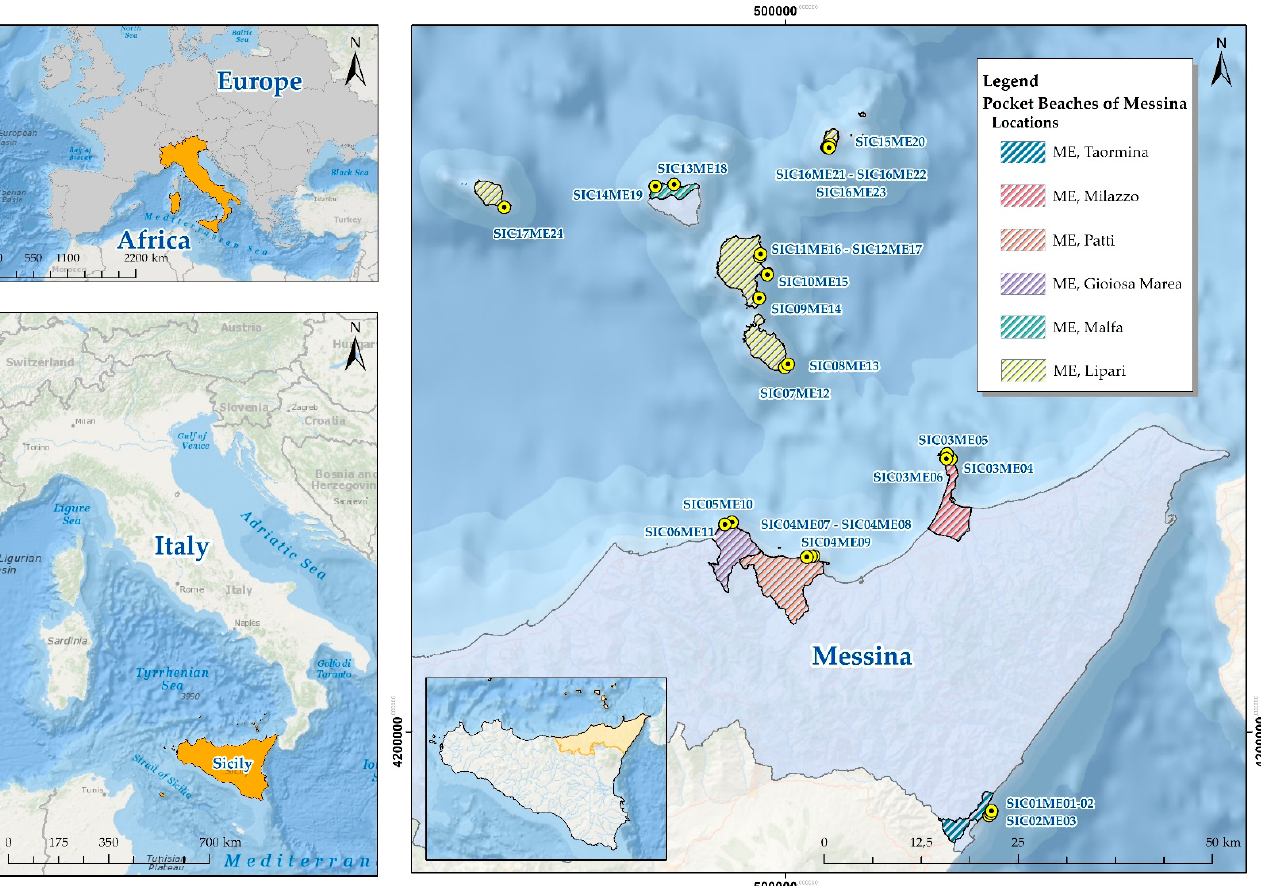
Figure 1 . Location of 24 PBs studied on the coast of six municipalities (Taormina, Milazzo, Patti, Gioiosa Marea, Lipari, and Malfa) of the province of Messina. From the southeast to northwest of Messina province, we studied 3 PBs on the coastal city of Taormina, 3 PBs on the coast of Milazzo, 3 PBs on the coast of Patti, 2 PBs on the coast of Gioiosa Marea, 11 PBs on the coast of Aeolian Island (Lipari), and 2 PBs on the coast of Malfa.